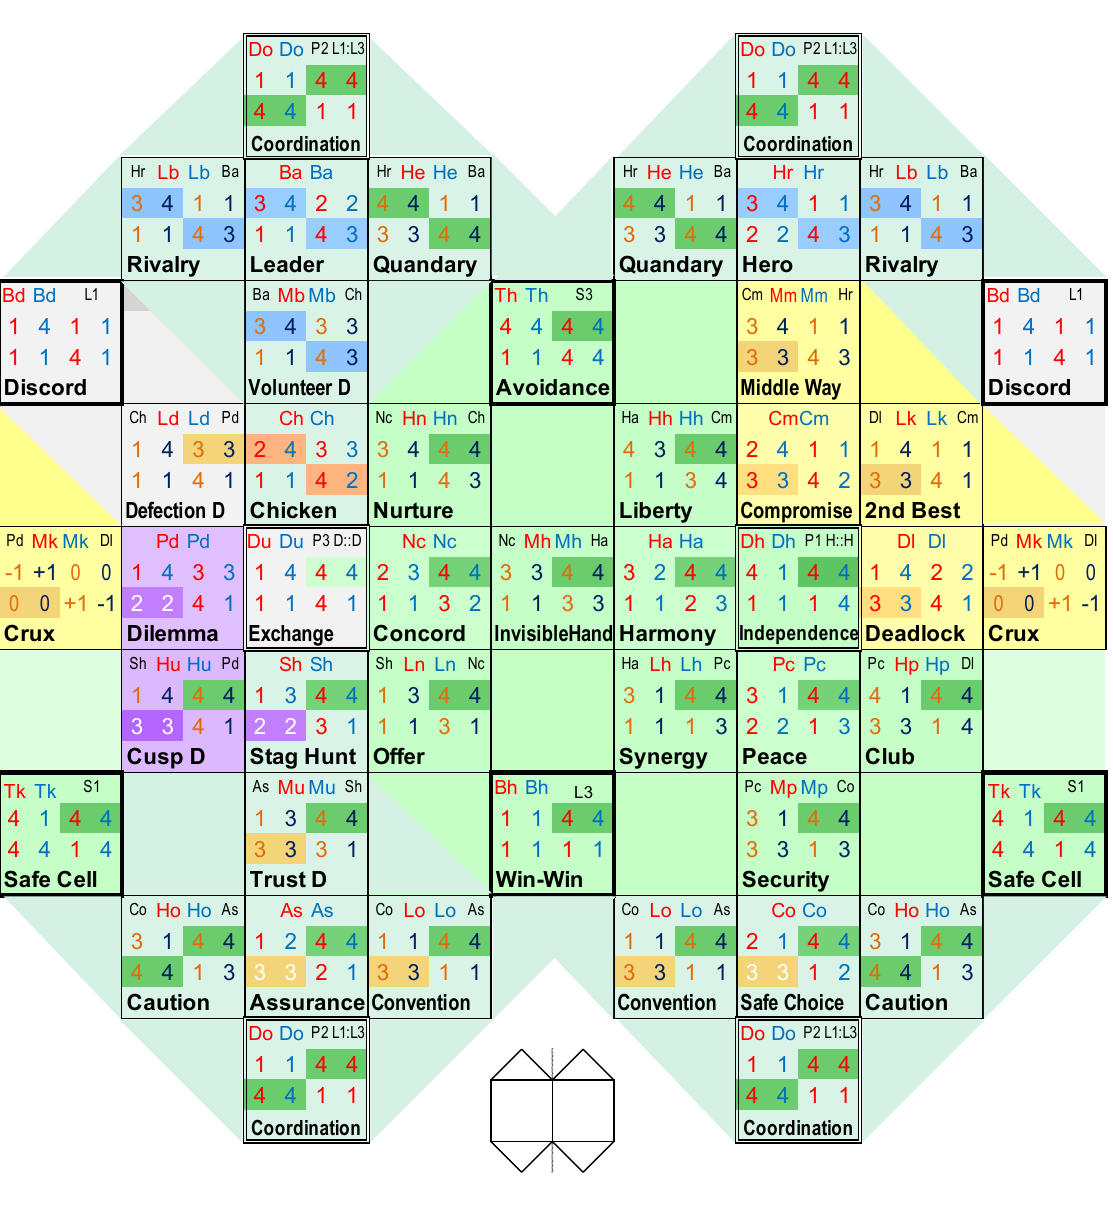
Figure A8 . Topology of symmetric 2x2 games with ties. The simplest Basic and Safe symmetric games with three ties and one like or dislike form the corners of a box (disdyakis cube). Independence and Exchange are each in the center of sides of the box, surrounded by their descendants created by symmetrically breaking ties. Coordination games form triangular “flaps” at the top and bottom, with Primal Coordination making a “wormhole”